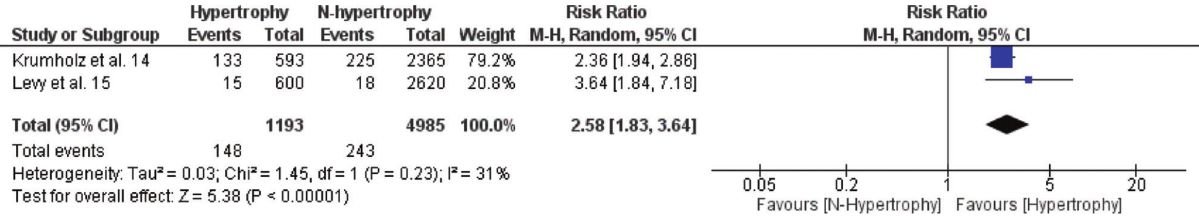
Figure 2.2 - The Risk Ratio and 95% confidence interval (CI) in the cardiovascular mortality, for Left Ventricular Hypertrophy group versus the Control group.